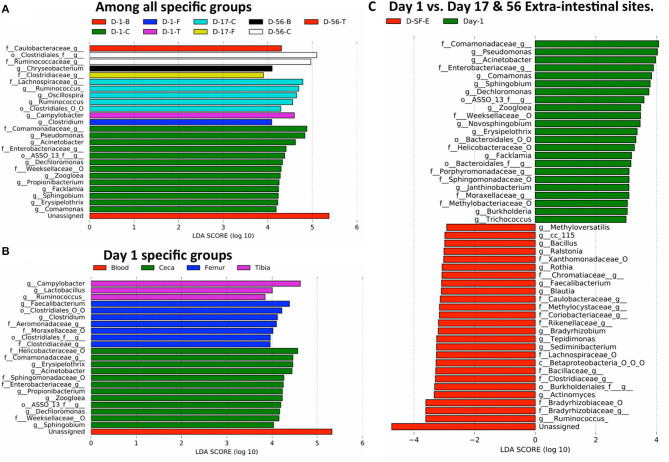
Translocation of potential bacteria from gut to extra-intestinal sites of chickens. The taxonomic abundance table at the genus level was used for the LEfSe analysis. Differentially abundant taxonomic features among: (A) specific groups (4 sites × 3 days = 12 specific groups/sample types) of entire study, (B) day 1 specific groups (blood, ceca, femur, and tibia), and (C) day 1 (all 4 sites) vs. days 17 and 56 extraintestinal sites (D-SF-E). f__, family; g__, genus; o__, order; O, other, and the taxonomic level is connected by an underscore (_).